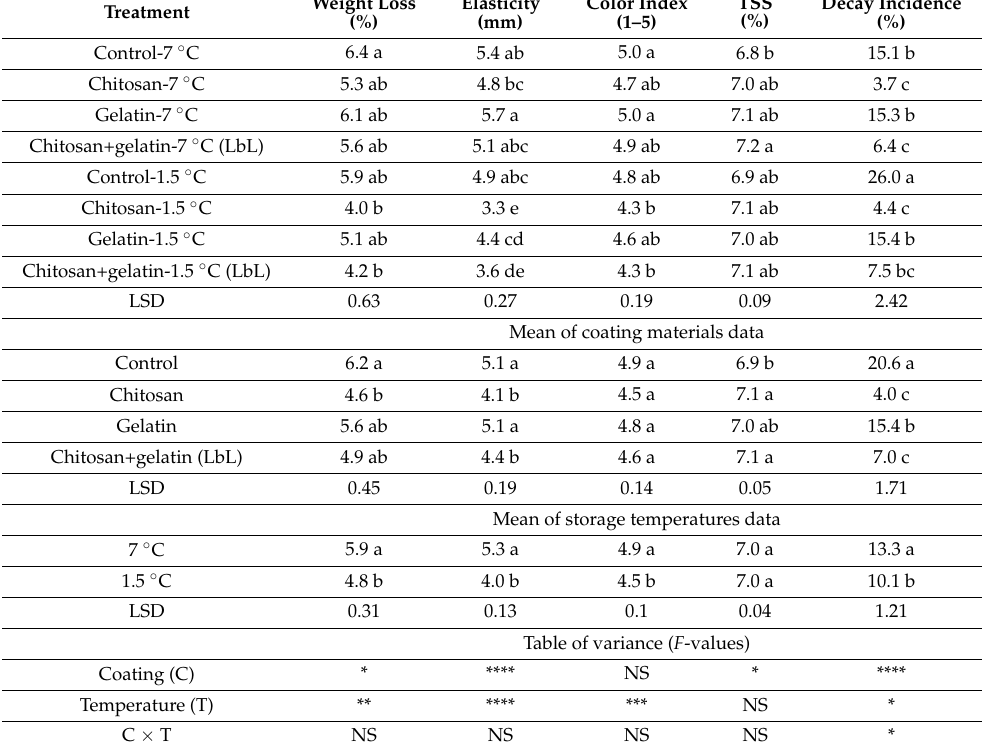
Table 1. The effects of different coating materials and storage temperatures on red pepper fruit quality, in terms of weight loss (% of initial weight), elasticity (mm deformation), color index (1–5), total soluble solids (TSS; %) and the incidence of decay (%) after 21 d at 7 ◦ C or 1.5 ◦ C, followed by 3 d at 21 ◦ C. Mean data from three harvests are presented; each harvest consisted of two boxes with 20 fruit in each box.